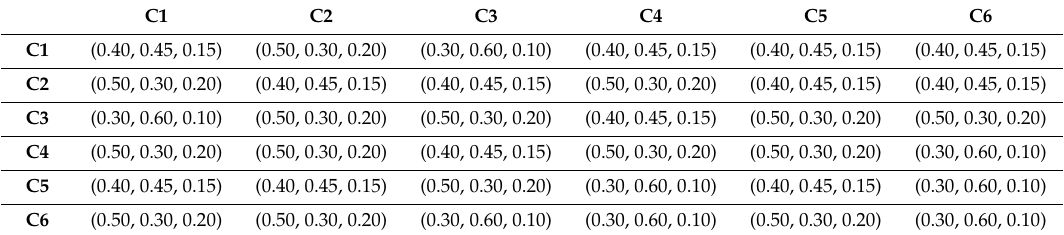
Table A3. Intuition fuzzy preference relationship of resources and environmental protection